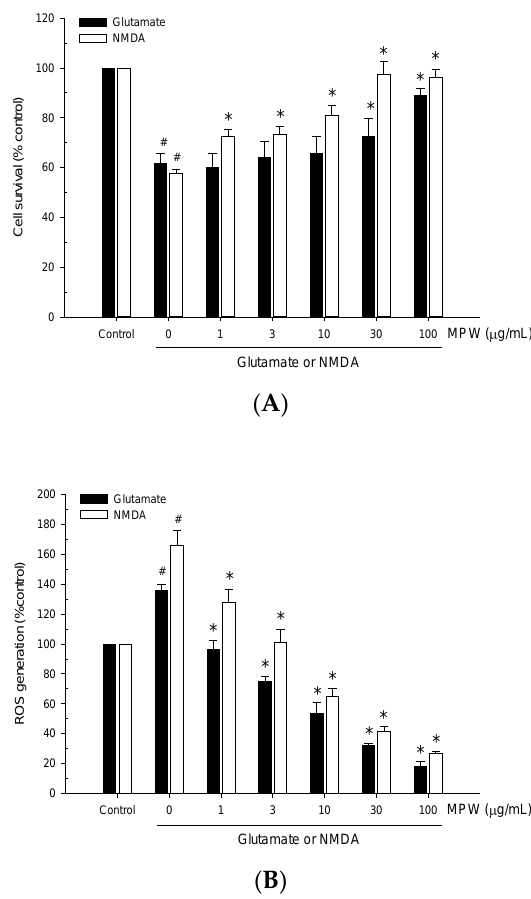
Figure 3. Effects of MPW on glutamate- or NMDA-induced neurotoxicity and ROS generation in primary rat cortical cells. ( A ) The cultured cells were exposed to 100 μM glutamate or 300 μM NMDA for 15 min in the absence or presence of MPW at the indicated concentrations. The cell viability was determined by the MTT reduction assays, and the cell survival was calculated as described in Figure 1. ( B ) The cultured cells were pre-incubated with 10 μM DCFH-DA for 30 min at 37 ℃ in the dark and then treated with 100 μM glutamate or 300 μM NMDA for 2 h in the absence or presence of MPW at the indicated concentrations. The intracellular ROS levels were measured by the fluorescence detection of 2′,7′-dichlorofluorescein and calculated as described in Figure 1. Each data point represents the mean ± S.E.M. from at least three independent experiments conducted in duplicate (#, p < 0.05 vs. the vehicle-treated control cells without MPW; *, p < 0.05 vs. the glutamate- or NMDA-treated cells without MPW).